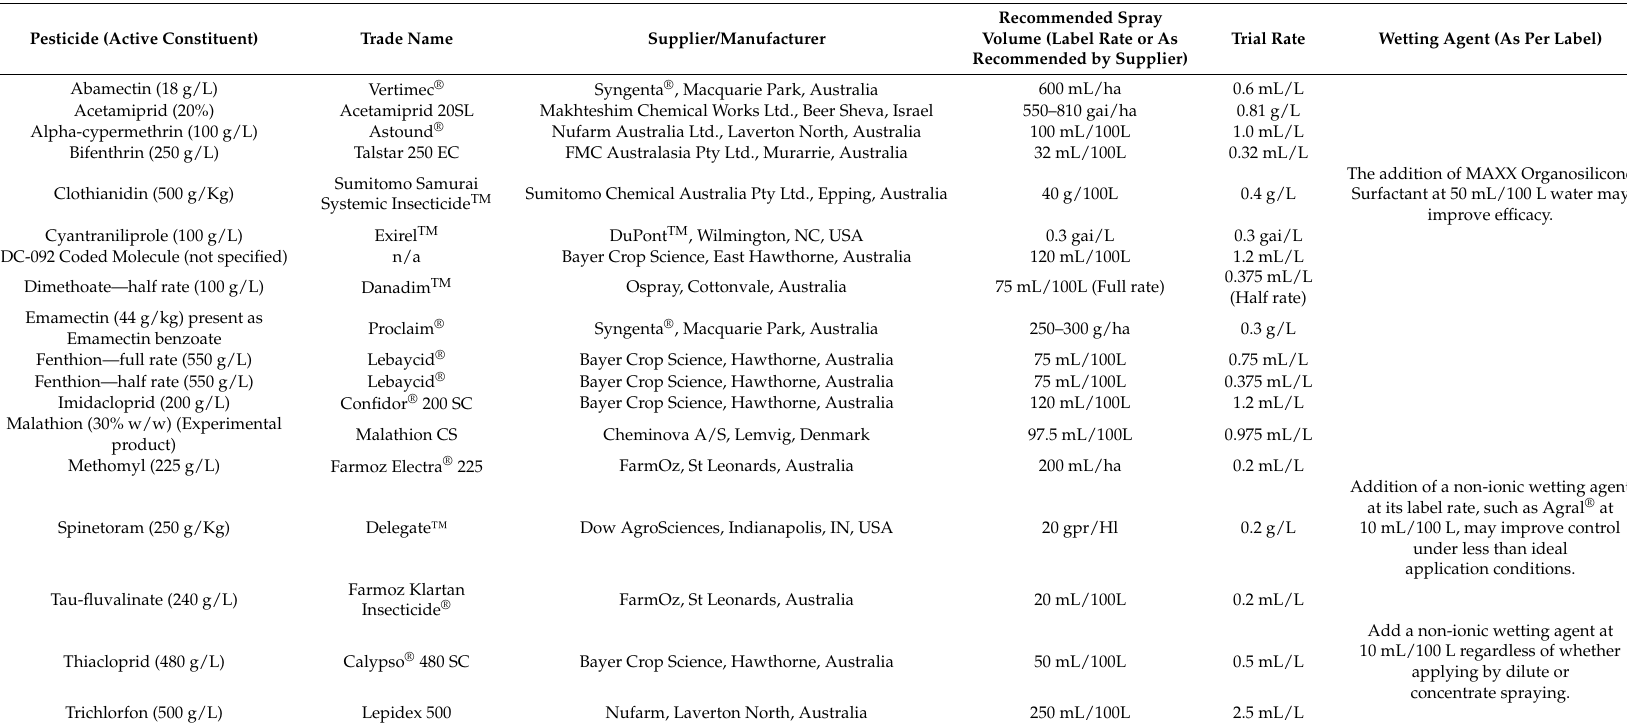
Table 1. The selected trial chemicals, trade name, supplier/manufacturer, recommended rate, trial rate, and wetting agents for Bactrocera tryoni pesticide application.